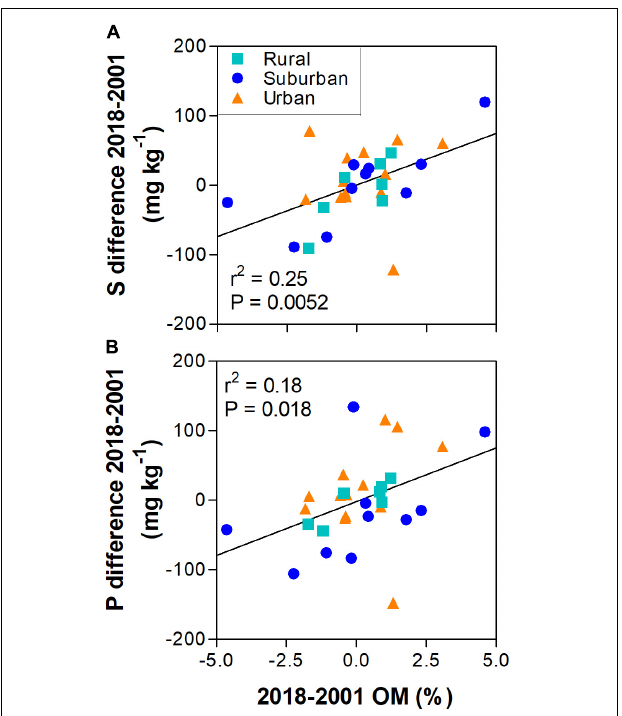
FIGURE 7 | Correlation between the change in sulfur (A) , phosphorous (B) and the change is soil organic matter from 2001 to 2018. Points represent plot level data ( n =